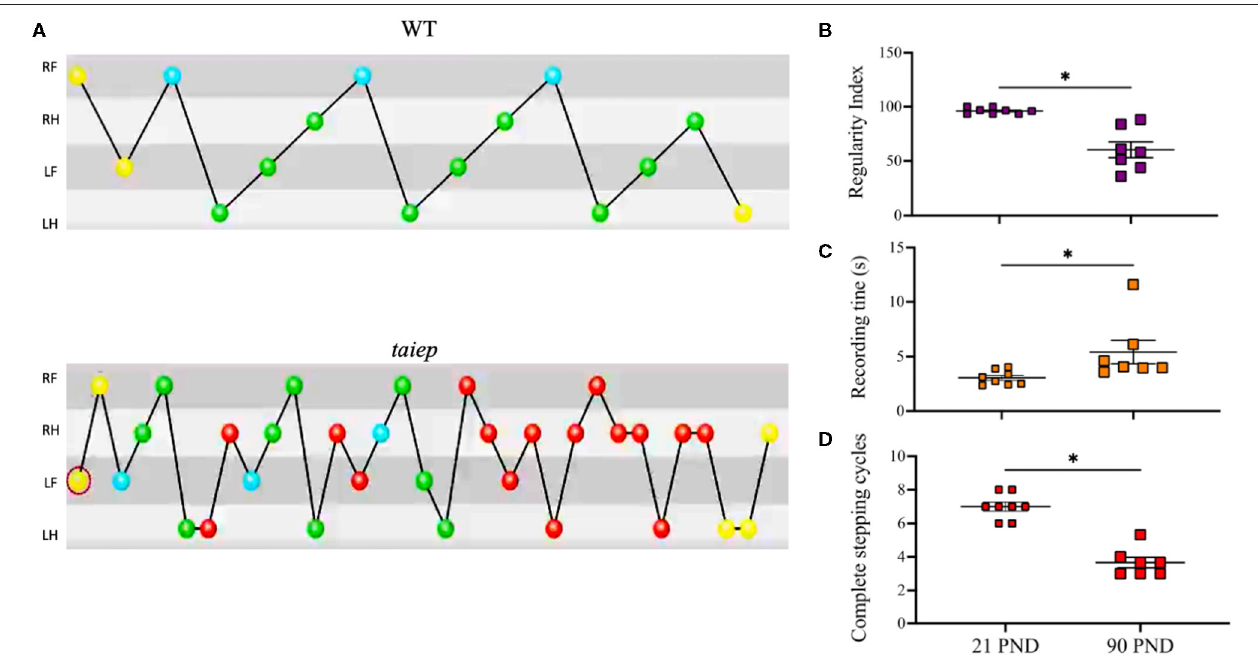
FIGURE 3 | Analysis of ataxic gait in the taiep rat. Stepping pattern and limb coordination shows that taiep rats performed more steps of short distance to diminish ataxic gait to be able to cross the catwalk (A) . The regularity index decreases with the age of taiep rats (B) . The recording time increases (C) and the number of complete stepping cycles decreases (D) with the age of taiep rats (PND: postnatal days). Yellow circles: not taken into account; blue circles: start of a pattern; green: part of a pattern; red: not part of a pattern. Data were analyzed by Wilcoxon matched-pairs signed rank test. * p > 0.05 between groups. RF, Right Front; RH, Right Hind; LF, Left Front; LH, Left Hind.